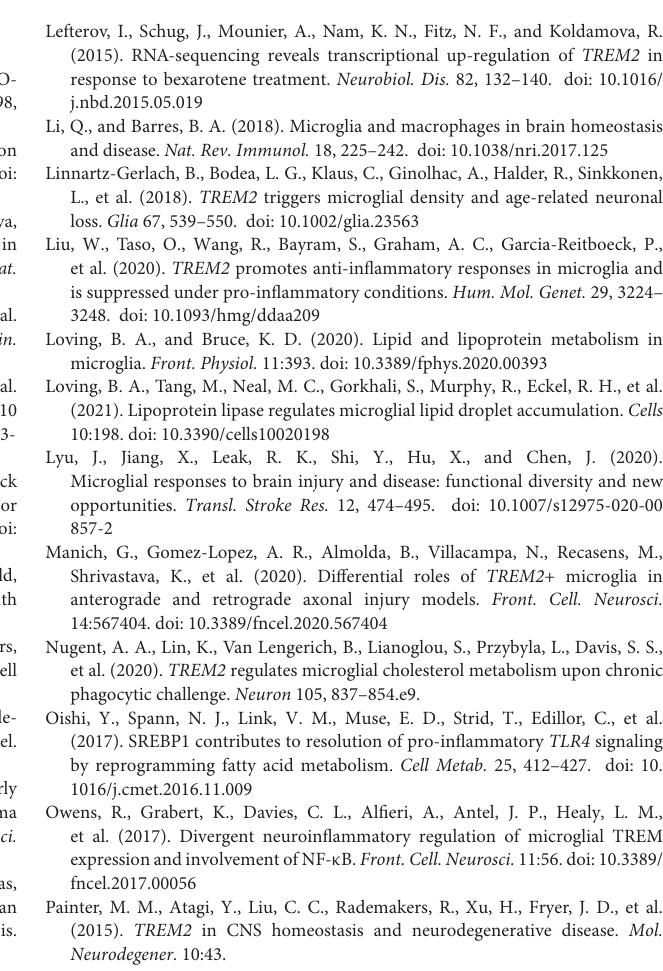
Supplementary Table 1 | The sequences of shRNA. Supplementary Table 2 | Antibodies in Western blot analysis. Supplementary Table 3 | Antibodies in immunofluorescence analysis. Supplementary Table 4 | The PCR primer sequences. Supplementary Table 5 | Definitions of neurological